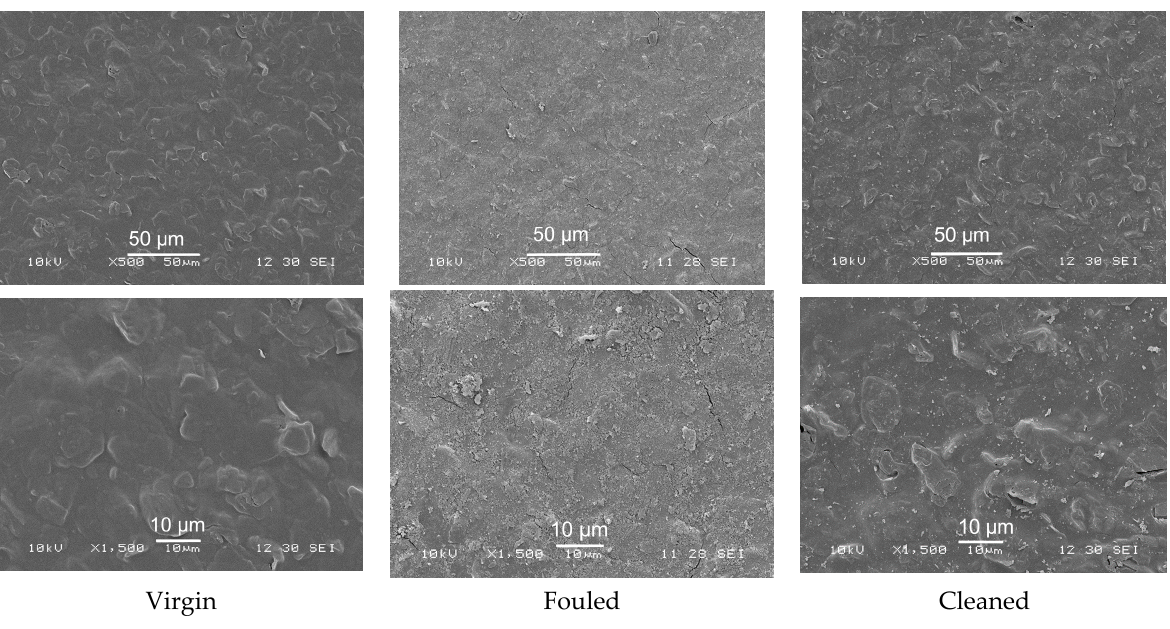
Figure 9. SEM images of virgin, BSA fouled and cleaned ( left to right ) PANI/EG composite membranes (applied potential = 30 V) with scale bar of 50, 10 μ m ( top to bottom ), respectively.